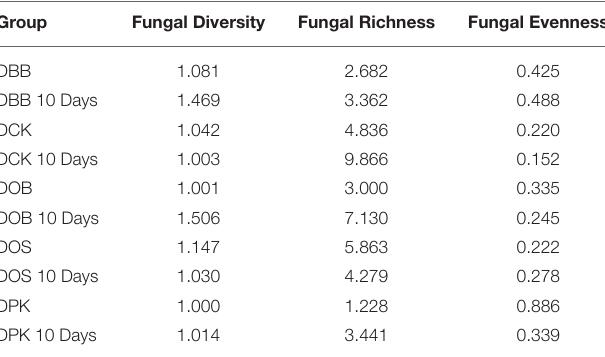
TABLE 2 | Fungal diversity, richness and evenness values in the five starters and in the fungal communities after 10 days of fermentation. Group Fungal Diversity Fungal Richness Fungal Evenness DBB 1.081 2.682